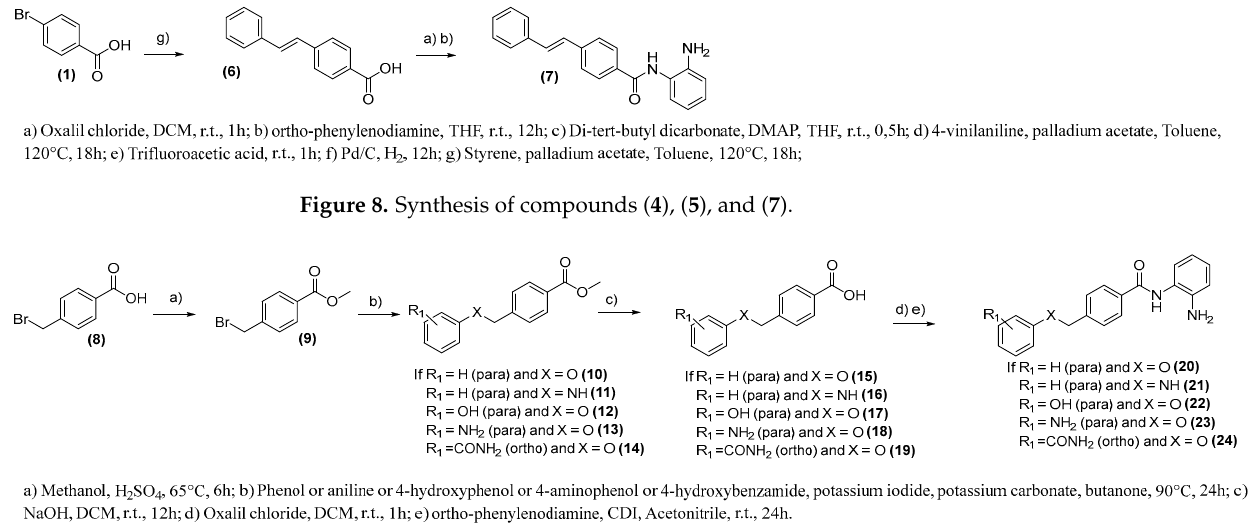
Figure 8. Synthesis of compounds ( 4 ), ( 5 ), and ( 7 ).